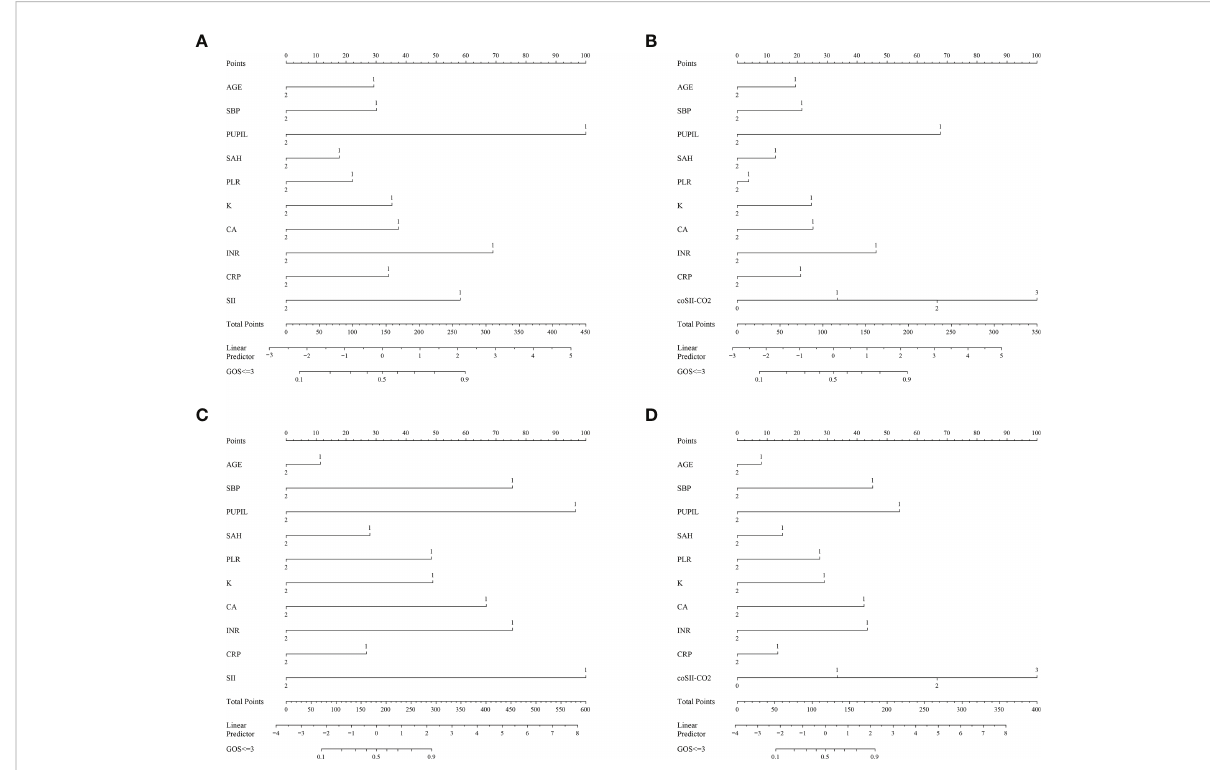
FIGURE 4 Establishment of the SII and coSII-CO 2 nomograms in the training and validation groups. (A, B) Nomograms based on SII and coSII-CO 2 in the training group. (C, D) Nomograms based on SII and coSII-CO 2 in the validation